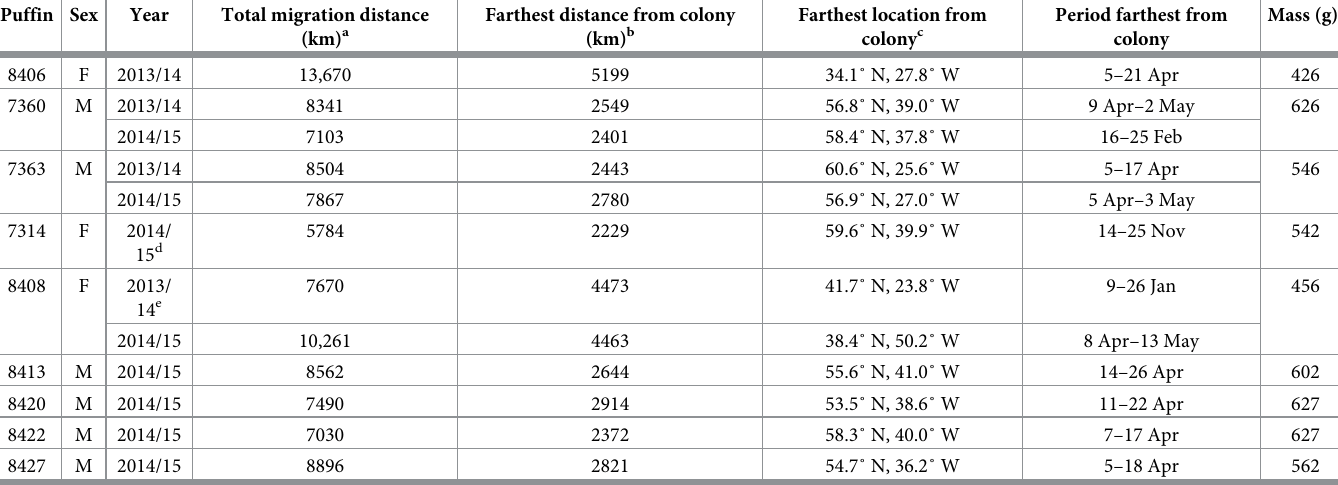
(Table 1). Notable differences in migratory phenology, route, and distance were observed between male and female puffins and among females, but not among males. Table 1. Total migration distance and farthest distance from breeding colony for nine Atlantic puffins breeding at a colony in northwest Greenland. Puffin Sex Year Total migration distance Farthest distance from colony Farthest location from Period farthest from Mass (g) f (km) a (km) b colony c colony